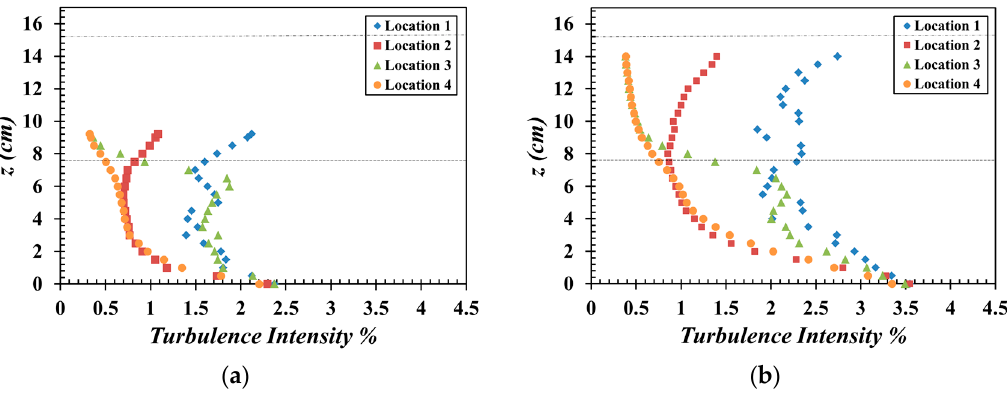
Figure 12. Turbulence intensity (%) profiles at critical locations (1, 2, 3, and 4) ( a ) for Case A, and ( b ) for Case B.